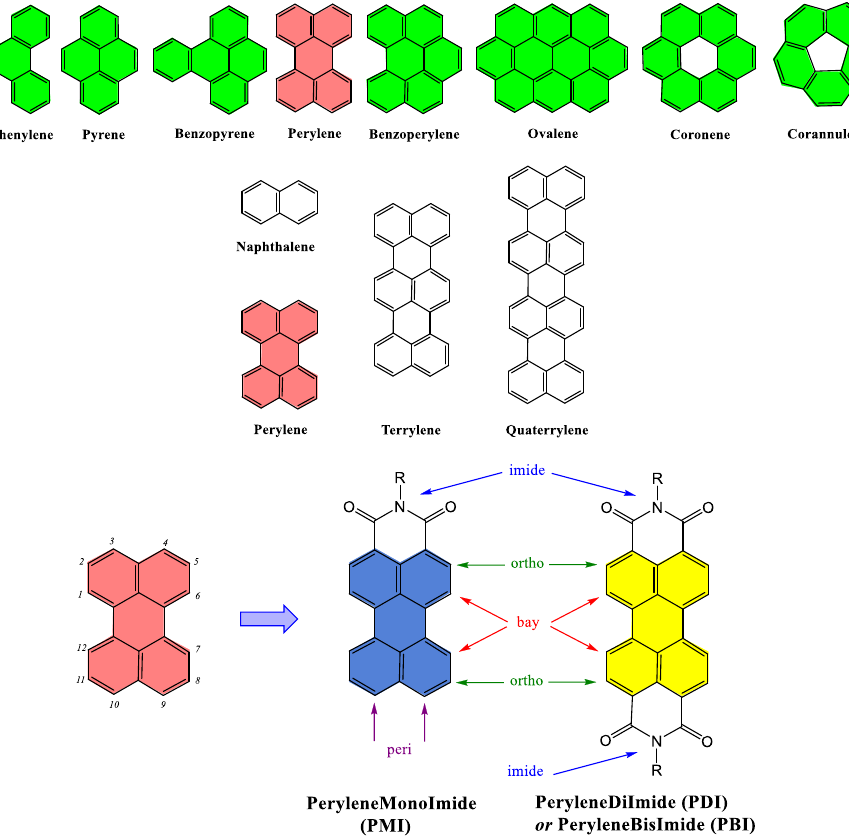
Figure 1. Representation of polycyclic aromatic hydrocarbon (PAH) structures, more specifically the rylene dyes and their emblematic leaders perylenediimide (PDI) or perylenebisimide (PBI) and perylenemonoimide (PMI). In the review, the colour code is as follows: the backbone is coloured green for PAHs, red for perylenes including perylene mono- and dianhydride starting materials, yellow for PDI derivatives and blue for PMI derivatives.